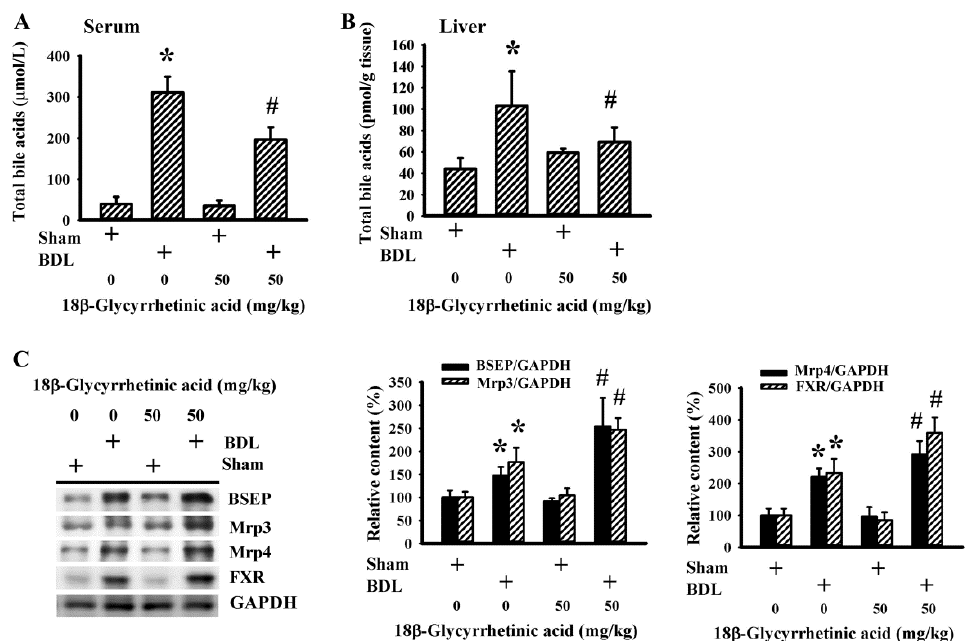
Figure 4. 18 β -Glycyrrhetinic acid alleviated BDL-induced retention of bile acids in the treatment study. The serum ( A ) and hepatic levels ( B ) of total bile acids were measured. ( C ) Protein contents in liver tissues were measured using Western blot with indicated antibodies. Representative blots and the quantitative data are shown. * p < 0.05 vs. the sham vehicle group and # p < 0.05 vs. the BDL vehicle group, n = 8.